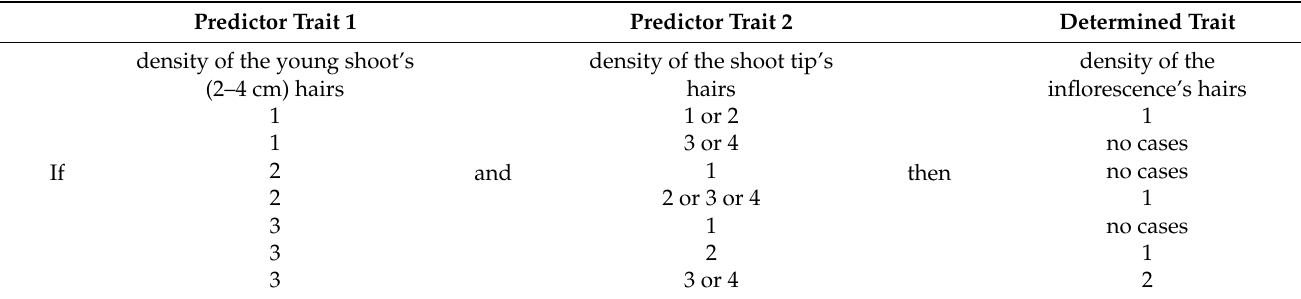
can be created by combining the 1 T 2